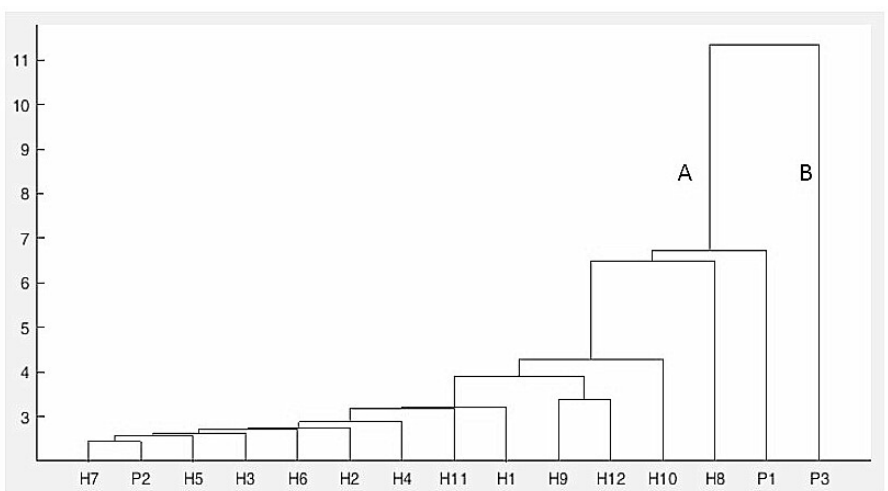
Figure 6. Dendrogram of the three Streptocarpus parents and their F1 hybrids derived from cluster analysis (HCA) cluster analysis of the FT-IR spectra. hierarchical cluster analysis (HCA) cluster analysis of the FT-IR spectra.